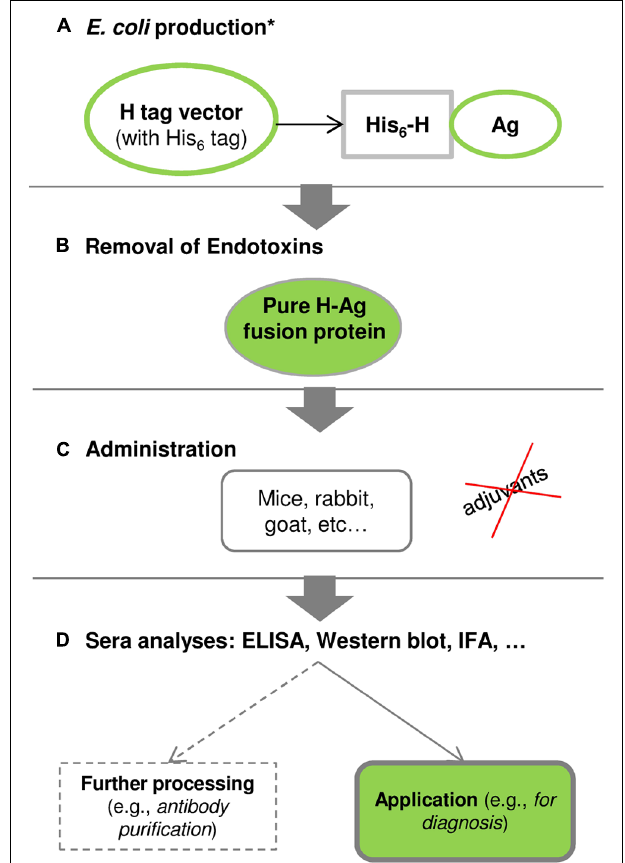
FIGURE 4 |The schematic pathway from gene to antibody using the H fusion tag (Costa etal., 2013c). (A) Production of H-fused antigens in E. coli : *the antigen-codifying gene is inserted into a H-tag expression vector, and protein production and purification are optimized following the conditions presented in Figure 1 . (B) E. coli endotoxins can be removed using a commercial endotoxin-removal kit or by hydrophobic interaction chromatography. (C) Purified H-fused antigens can be administrated into mice, rabbits, goats, among others, and this procedure is conducted without adjuvants. (D) The produced sera are analyzed by enzyme-linked immunosorbent assay (ELISA),Western blot, immunofluorescence assay (IFA), among others, to validate the specificity and practical application of polyclonal antibodies. Further processing may be required in order to